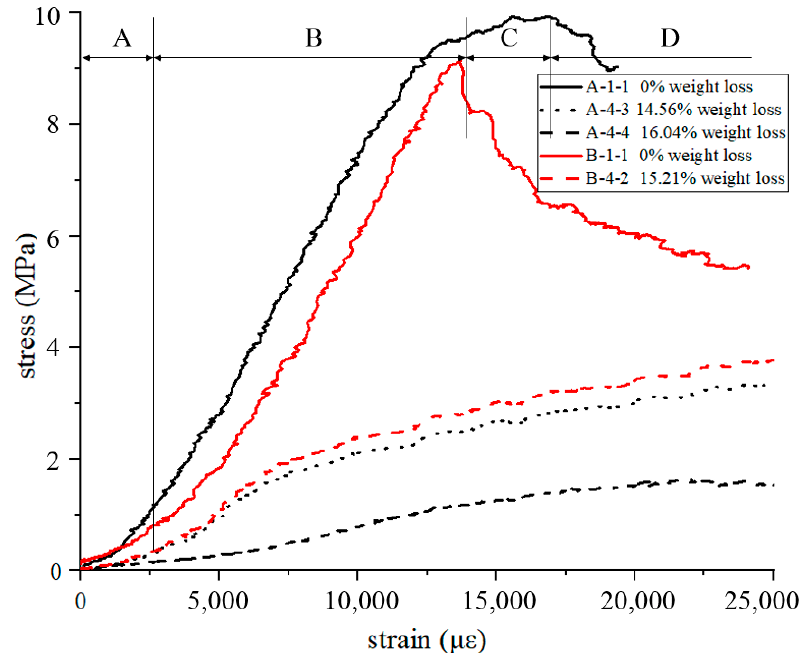
Figure 2. Stress-strain curve of A-1-1, A-4-3, A-4-4, B-1-1, B-4-2.